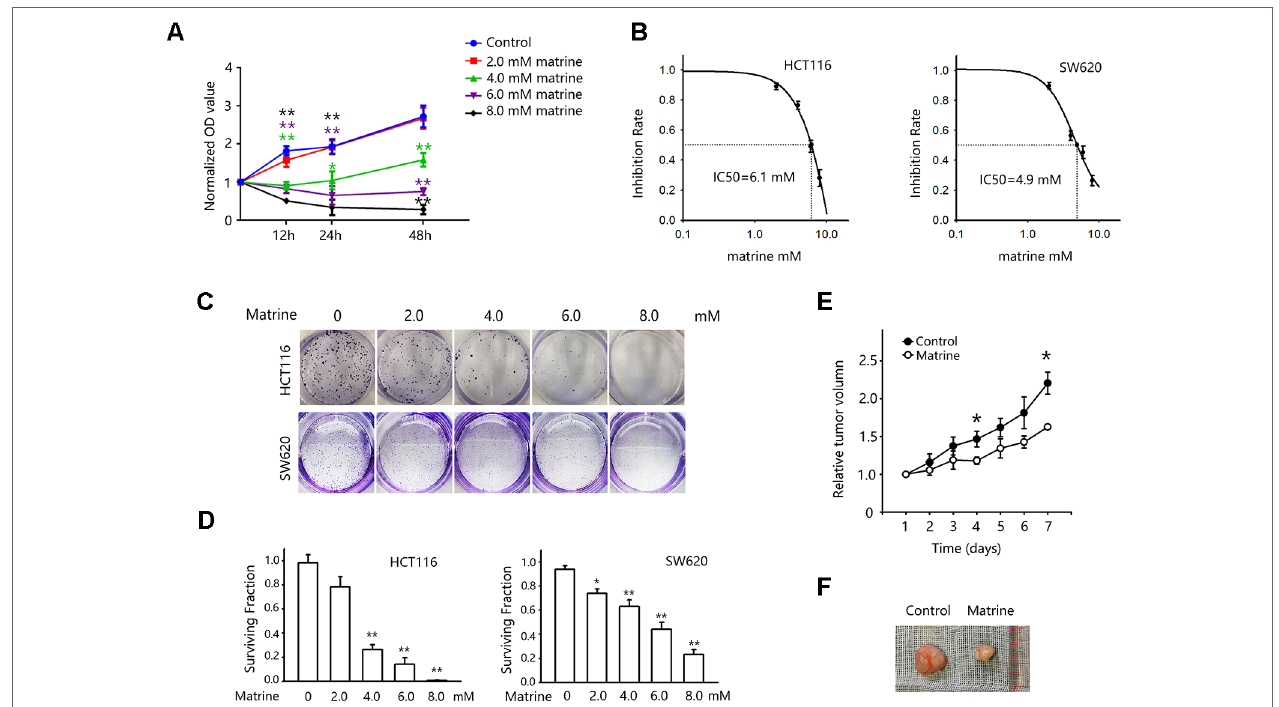
FIGURE 1 | Matrine inhibited the growth of colon cancer cells in vitro and in vivo. (a) 3-(4,5-Dimethylthiazol-2-yl)-2,5-diphenyltetrazolium bromide (MTT) assay to examine cell viability after matrine treatment. Cells were treated with different concentrations of matrine as indicated for 12~48 h. Data were expressed as mean ± SEM, n = 6. **, P < 0.01. (B) MTT assay to examine the IC50 of matrine on HCT116 and SW620 cells for 12 h of treatment. Data are expressed as mean ± SEM, n = 6. (C) Representative pictures of colony forming assay to show the growth inhibition effect of different concentrations of matrine on colon cancer cells. (D) Surviving fraction of colony forming assay. Data were expressed as mean ± SEM, n = 3. *, P < 0.05, **, P < 0.01. (E) Growth curve of colon cancer xenograft tumor with/without matrine treatment. Data were expressed as mean ± SEM, n = 5. *, P < 0.05. (F) Representative pictures of colon cancer xenograft tumors with/ without matrine